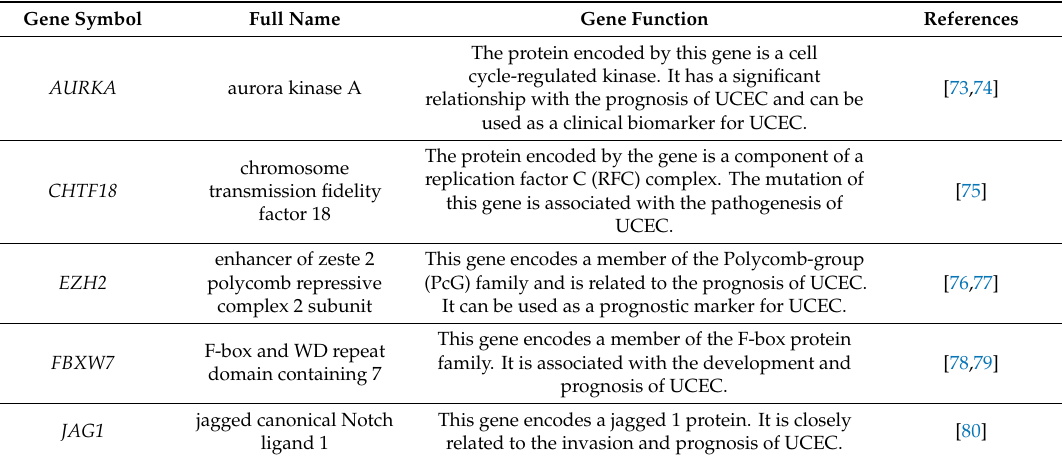
Figure 10. Core module network and survival analysis of POP1 and PSMB9 as biomarkers in uterine corpus endometrial carcinoma. ( a ) Core module network of uterine corpus endometrial carcinoma; ( b ) Survival analysis of POP1 as a biomarker in uterine corpus endometrial carcinoma; ( c ) Survival analysis of PSMB9 as a biomarker in uterine corpus endometrial carcinoma. Table 3. Known genes associated with uterine corpus endometrial carcinoma development, metastasis, and prognosis in the core module network.